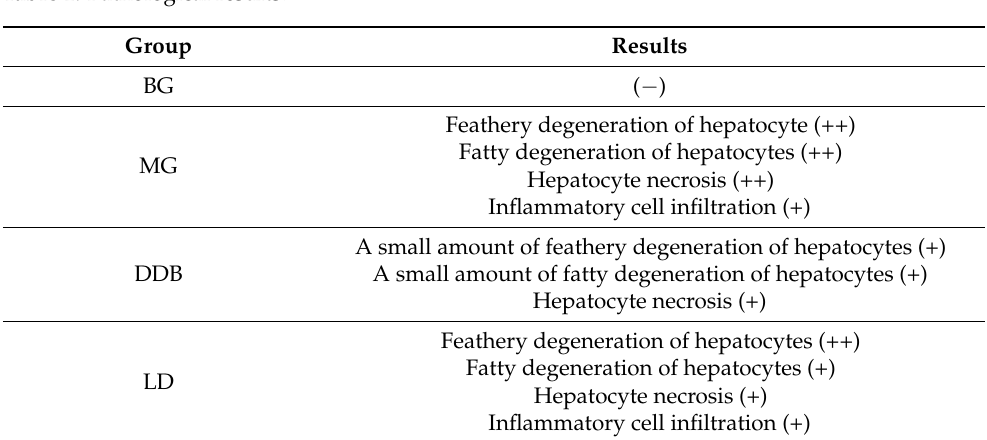
Figure 5. Electron microscopic observation. Table 1. Pathological